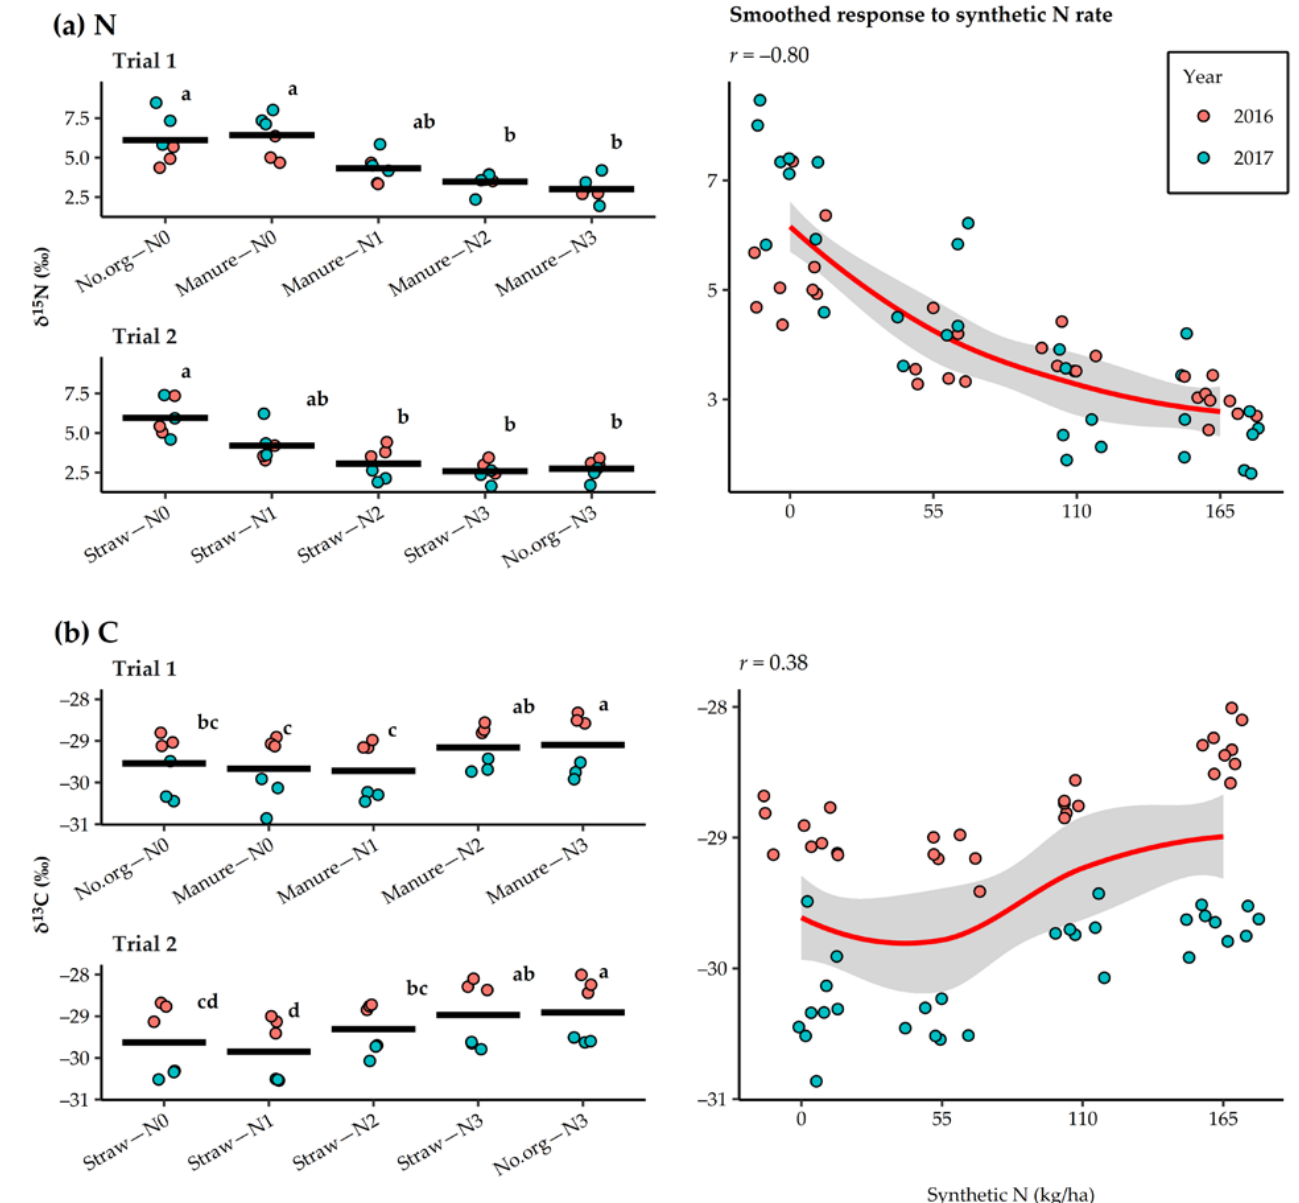
Figure 4. Response of δ 15 N and δ 13 C values ( a , b ) in oat grains to N rates and agronomic management practices applied in a long-term field experiment in 2016–2017. The crossbar indicates the mean value, while the dots represent individual observations. Means marked with different letters represent significant differences according to Tukey’s HSD test ( α = 0.05) within each trial. The smoothed conditional means method (Loes method) shows the overall observed response of the selected variables to the synthetic N rate and the correlation